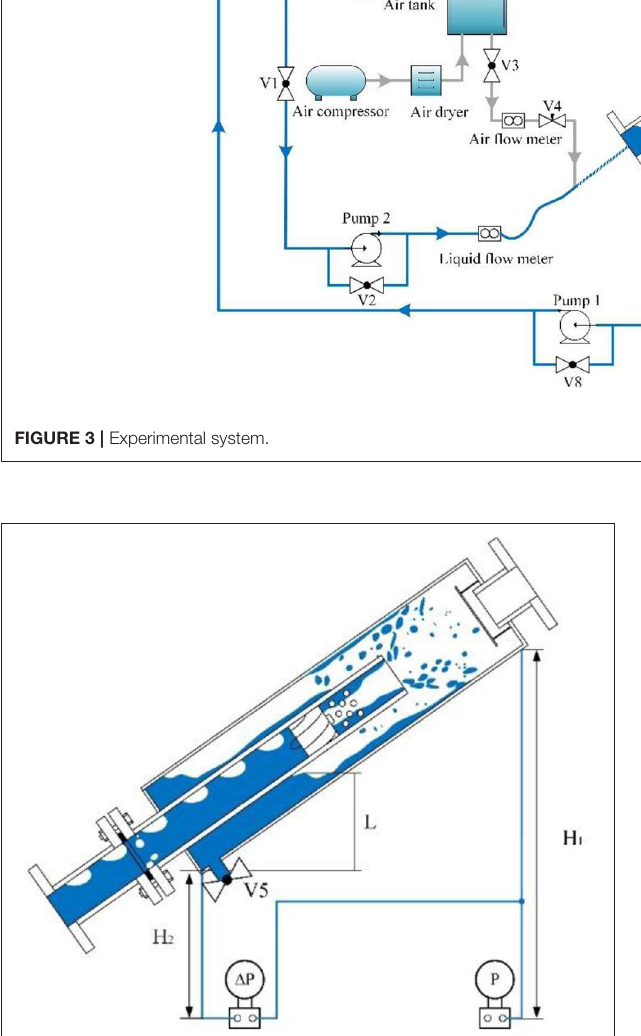
FIGURE 4 | The liquid level measurement principle of the differential pressure transmitter.